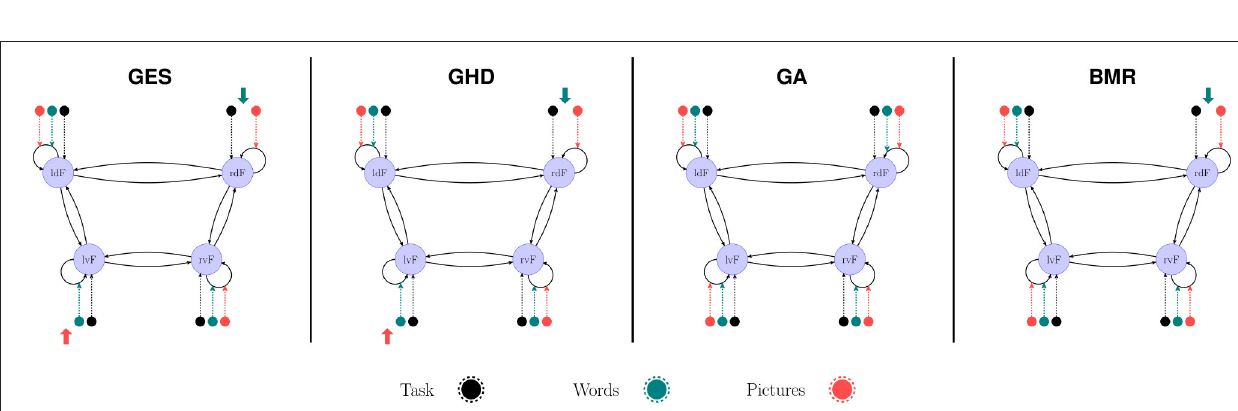
FIGURE 6 | Family-wise inference and family matched by model search methods. The top row shows random effects (RFX) family-wise model selection results over a group of subjects according to laterality, dorsoventral differences and task based differences. The bottom row shows percentage of model search results matching each of the families. The genetic algorithm (GA), the greedy Hamming-distance search (GHD), and post-hoc (PH) methods have the highest chance to match properties of the winning model family.